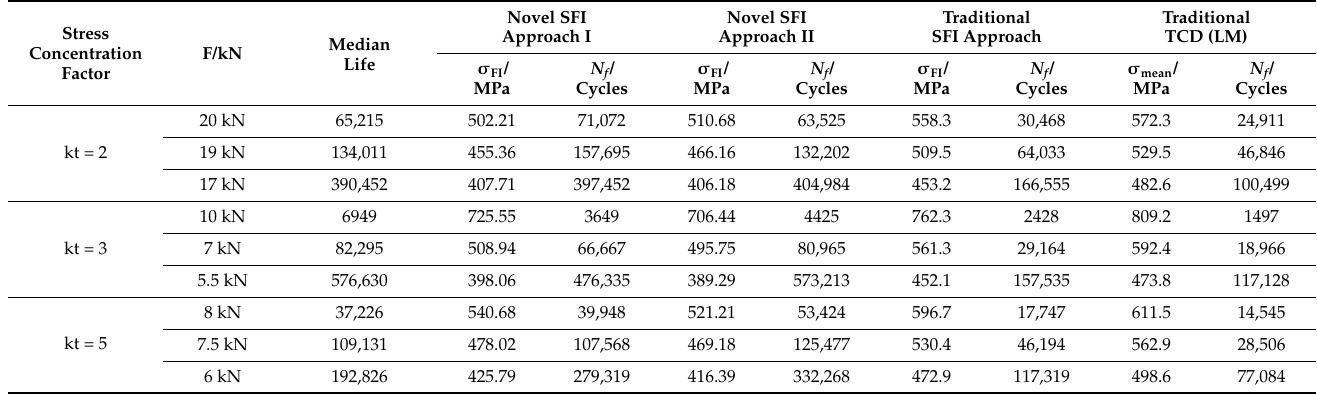
Table 6. Theoretical results of fatigue life for three notched specimens, calculated by four